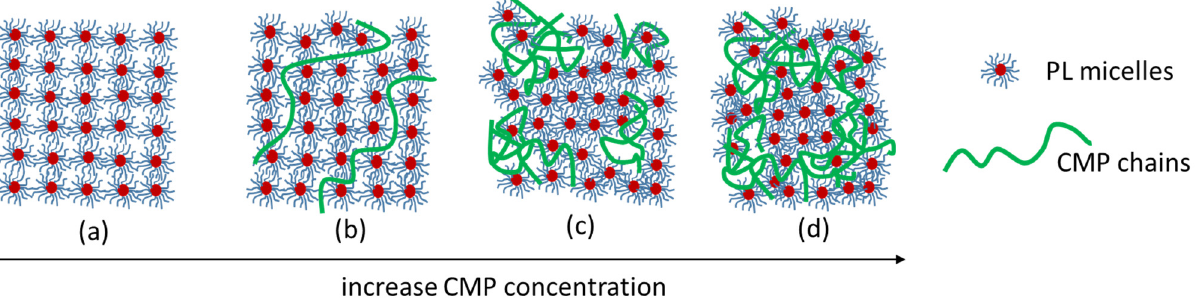
Figure 7. Schematic representation of the influence of CMP concentration on the PL17/CMP gelation behavior: PL17 ( a ), PL17/CMP 0.95 -0.4 ( b ), PL17/CMP 0.95 -1 ( c ) and PL17/CMP 0.95 -3 ( d ).